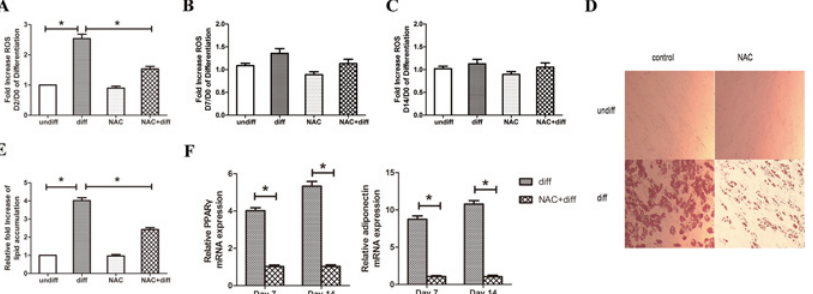
Fig 1. ROS mediate adipocyte differentiation of MSCs in vitro . (A) Fold increase in ROS on Day 2/Day 0 of differentiation. “ NAC ” and “ NAC+diff ” groups were treated with 5 mM NAC for 4 h prior to ROS measurement on Day 2. The NAC treatment was administered daily and lasted to Day 14. (B) Fold increase in ROS on Day 7/Day 0 of differentiation. (C) Fold increase in ROS on Day 14/Day 0 of differentiation. (D, E) NAC diminished lipid accumulation. Cells were fixed and stained with oil red O on Day 14. The oil red O was extracted with isopropanol and absorbance was measured at 518 nm. (F) Gene expression of PPAR γ and adiponectin was decreased in the presence of NAC at Day 7 and Day 14 of differentiation compared to control. * P < 0.05.